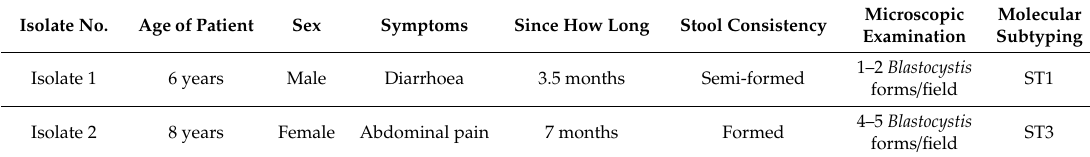
Table 1. Demographic data of the two isolates with microscopic and molecular identification.